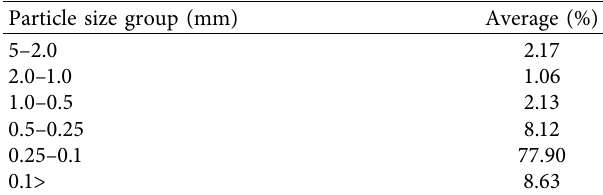
Table 1: Particle size composition of the fly ash. Particle size group (mm)